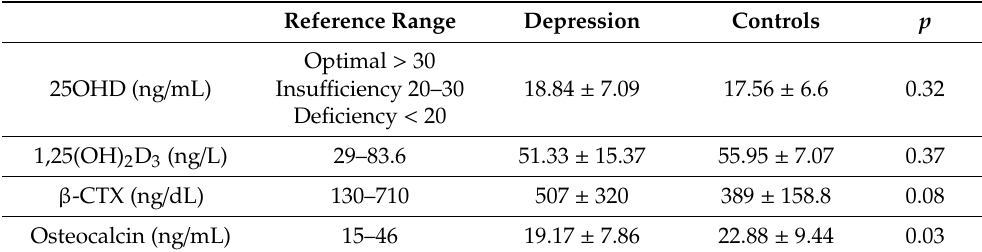
Table 2. Vitamin D and bone markers in patients with depression and the healthy controls.